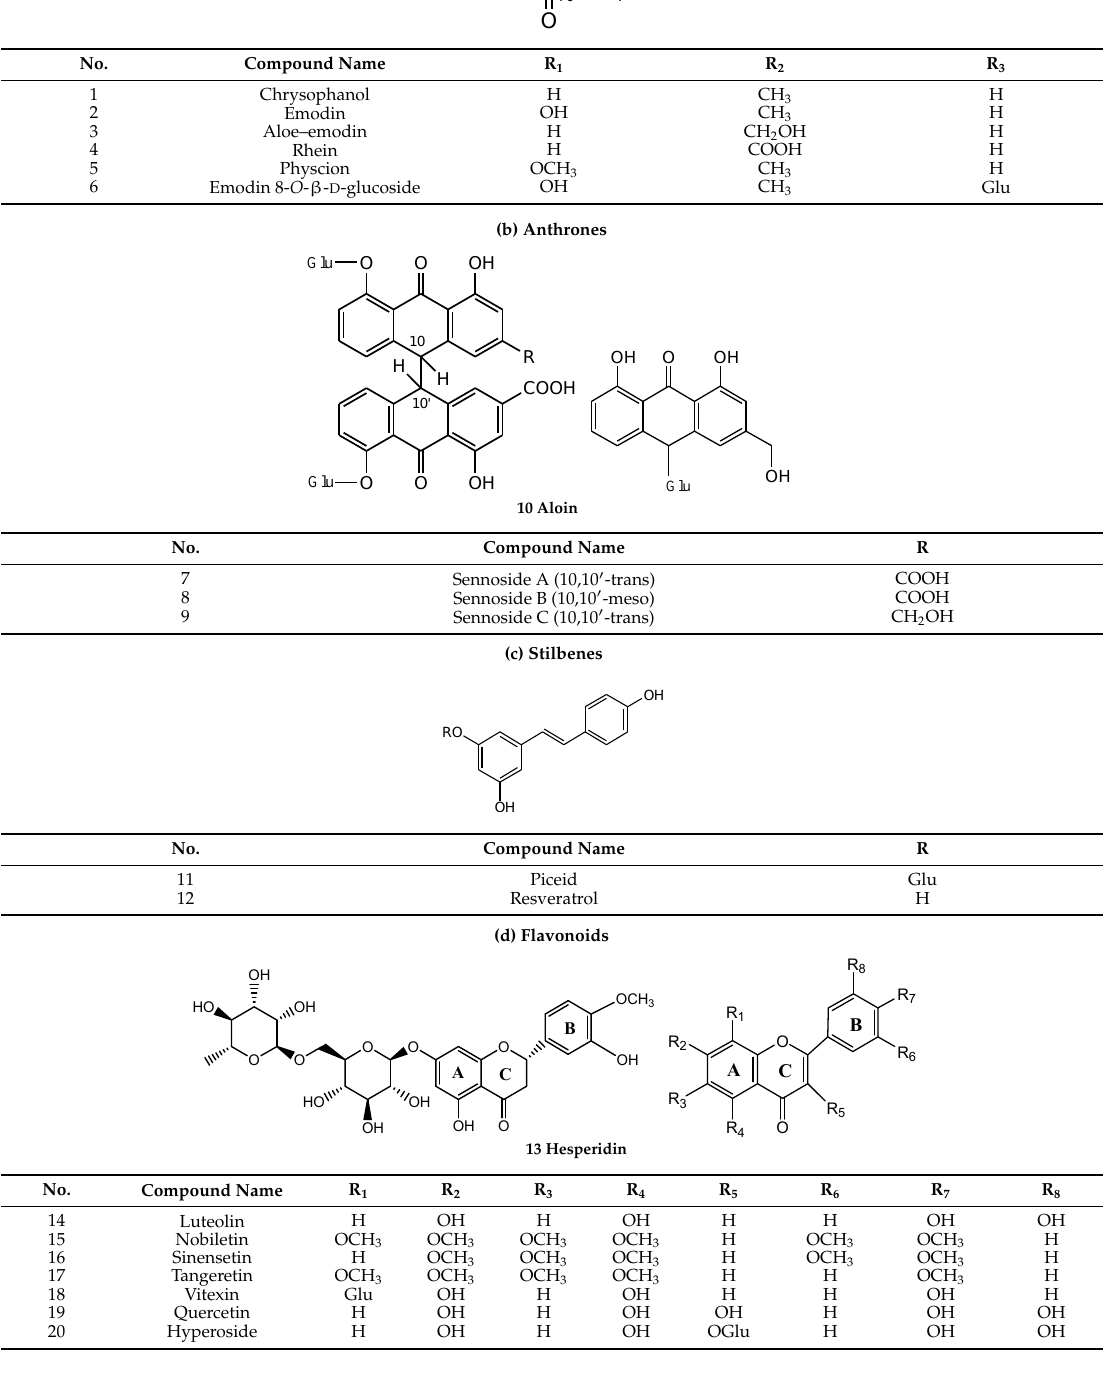
Table 2. Chemical structures of the twenty standard references. (a) Free anthraquinones and their glucosides OR